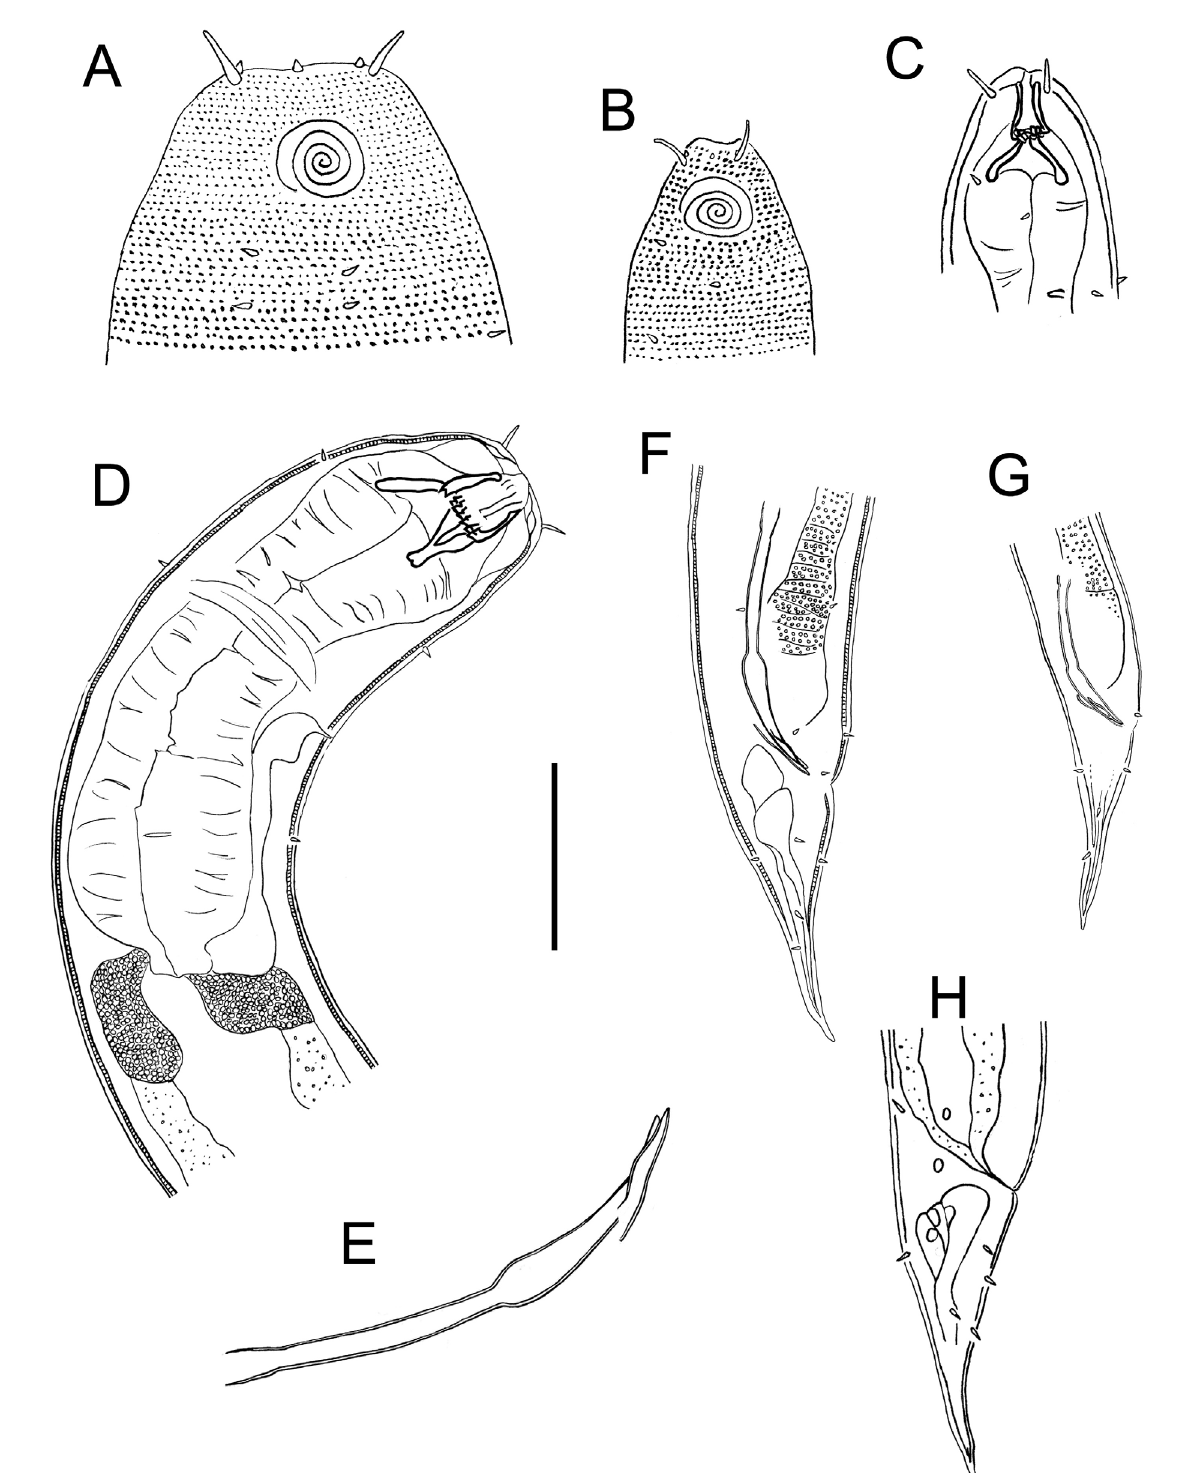
Fig. 8. Cobbionema trigamma sp. nov. A . Surface view of holotype head. B . Surface view of paratype male head. C . Buccal cavity of paratype male. D . Holotype anterior body region. E . Spicule and gubernaculum of holotype. F . Holotype posterior body region. G . Paratype male posterior body region. H . Female posterior body region. Scale bar: A-C = 30 µ m; D = 80 µ m; E = 36 µ m; F-G = 70 µ m; H = 40